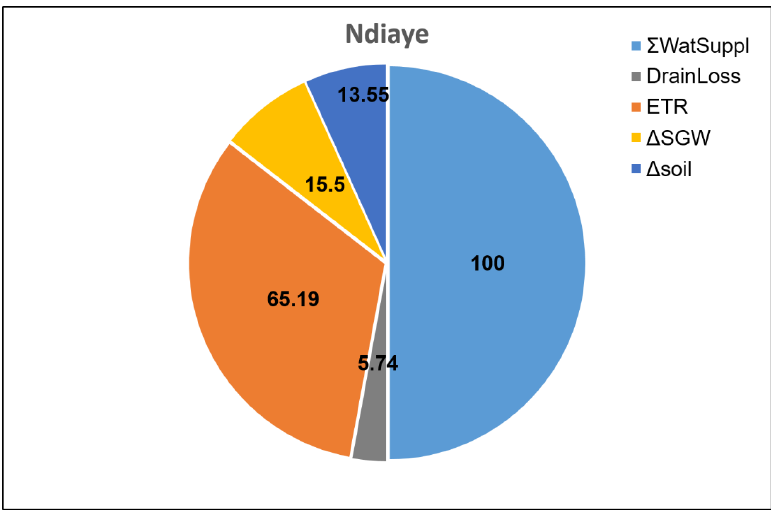
Figure 5. Description in percentages of the different terms of the water balance at the plot scale during irrigation.